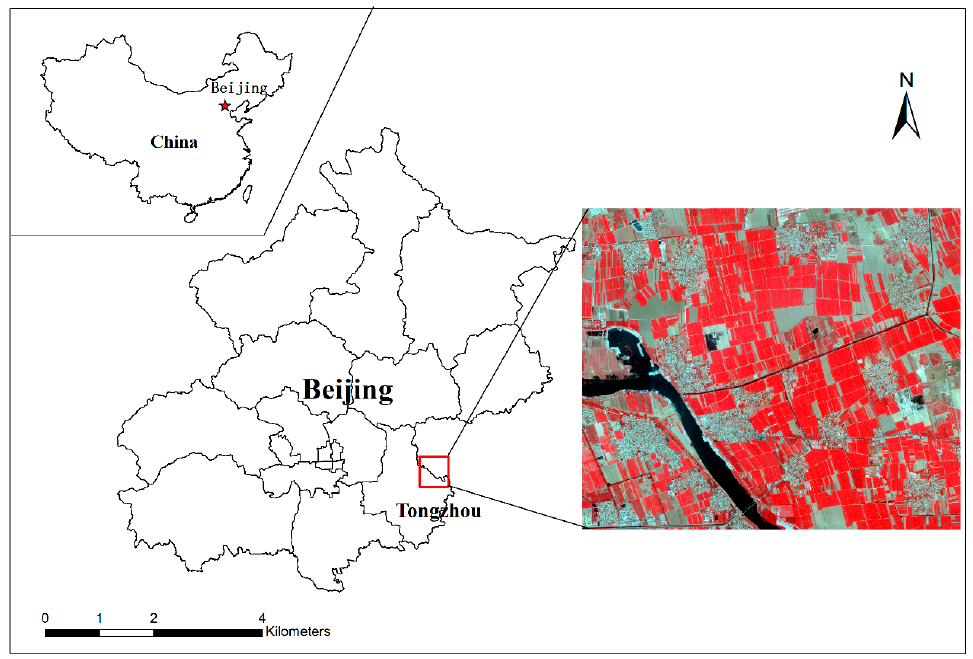
Figure 3. Study area and Quickbird (QB) imagery (bands combination = 4, 3, and 2).